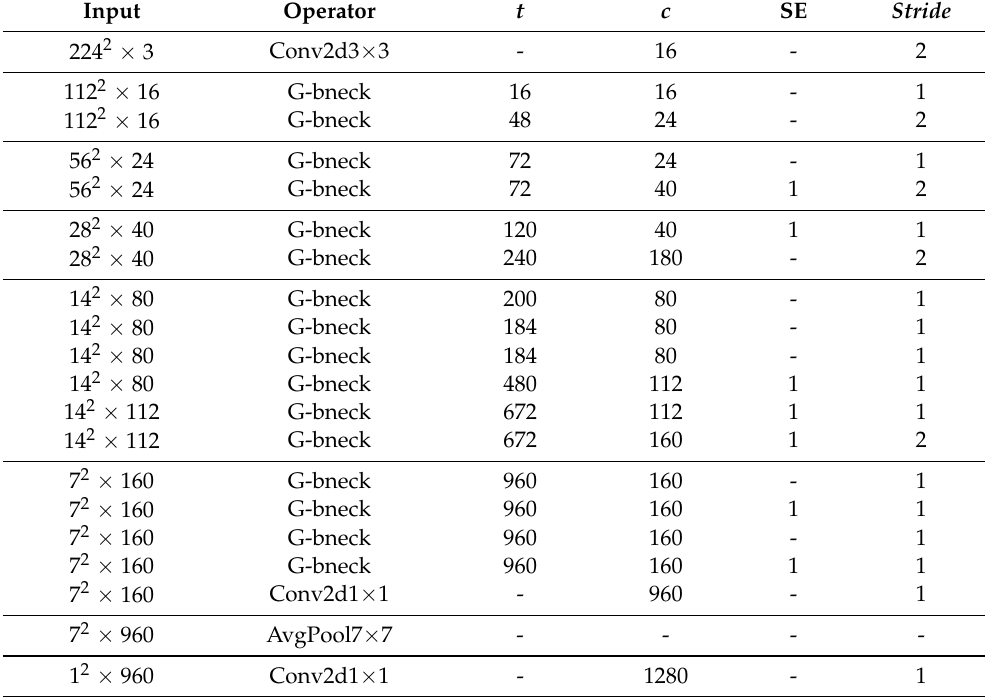
Table 3. GhostNet architecture